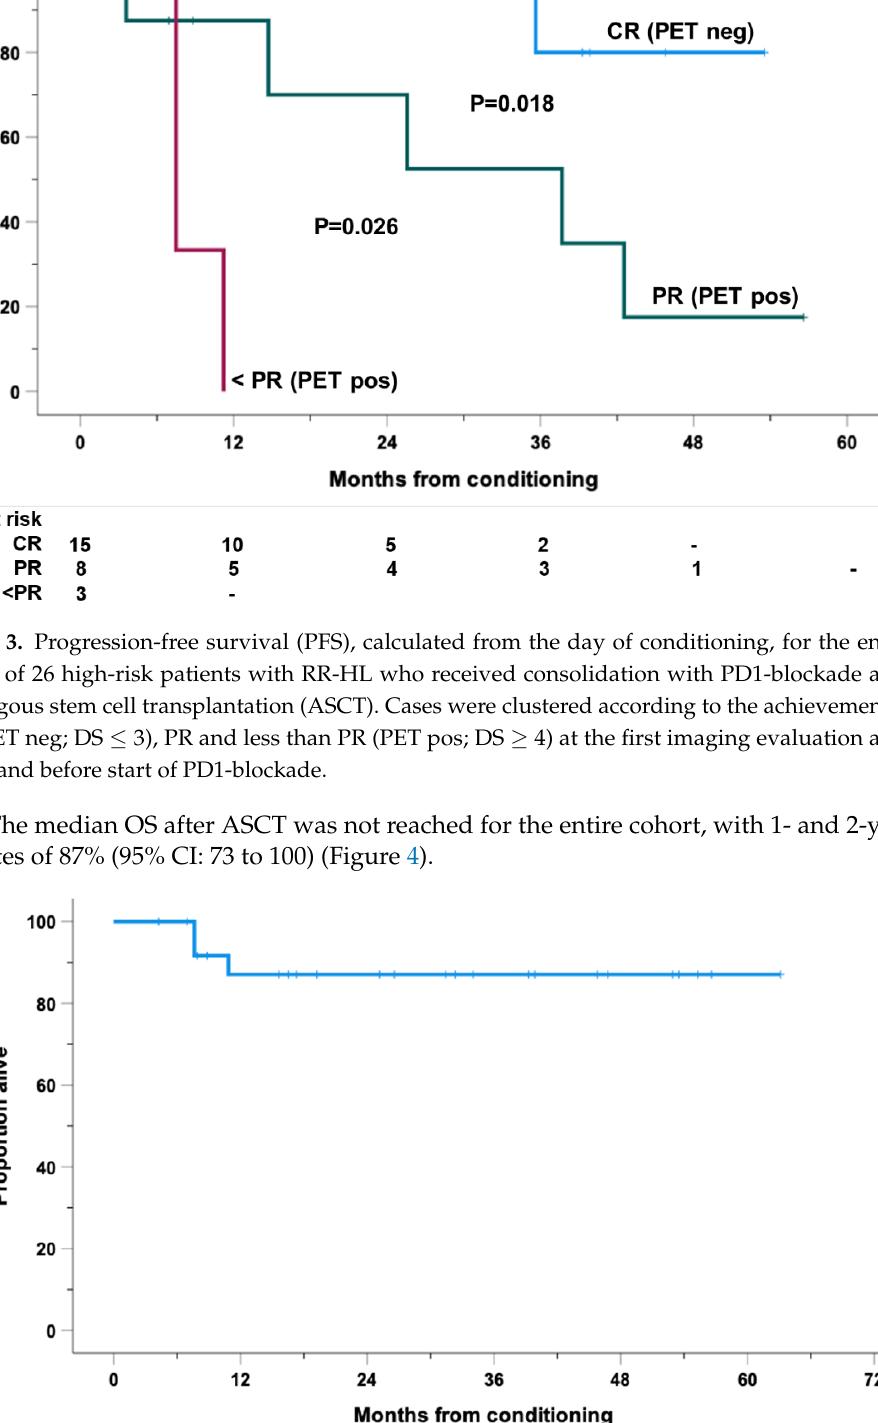
7 of 14 Figure 2. Cox univariate analyses of progression-free survival for 26 high-risk patients with RR-HL who received PD1-blockade after autologous stem cell transplantation (ASCT). The Forest plot sum- marizes the Cox univariate analysis for risk factors associated with post-ASCT progression. In contrast, landmark analyses evidenced that the attainment of the CR status (PET